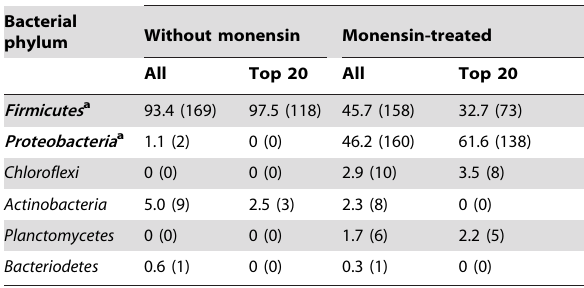
Table 3. Bacteria characterized from dairy wastewater treated with or without monensin and inoculated and incubated with EcO157 for 14 days.